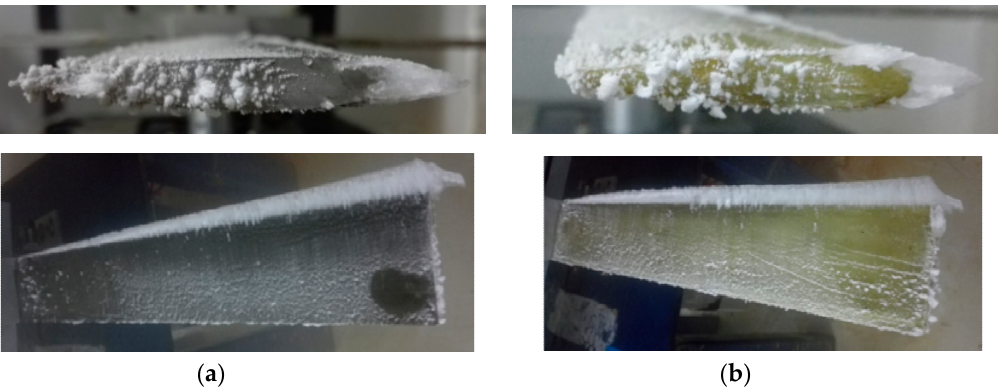
Figure 15. Ice shapes under different blade materials: ( a ) steel material; ( b ) composite material.